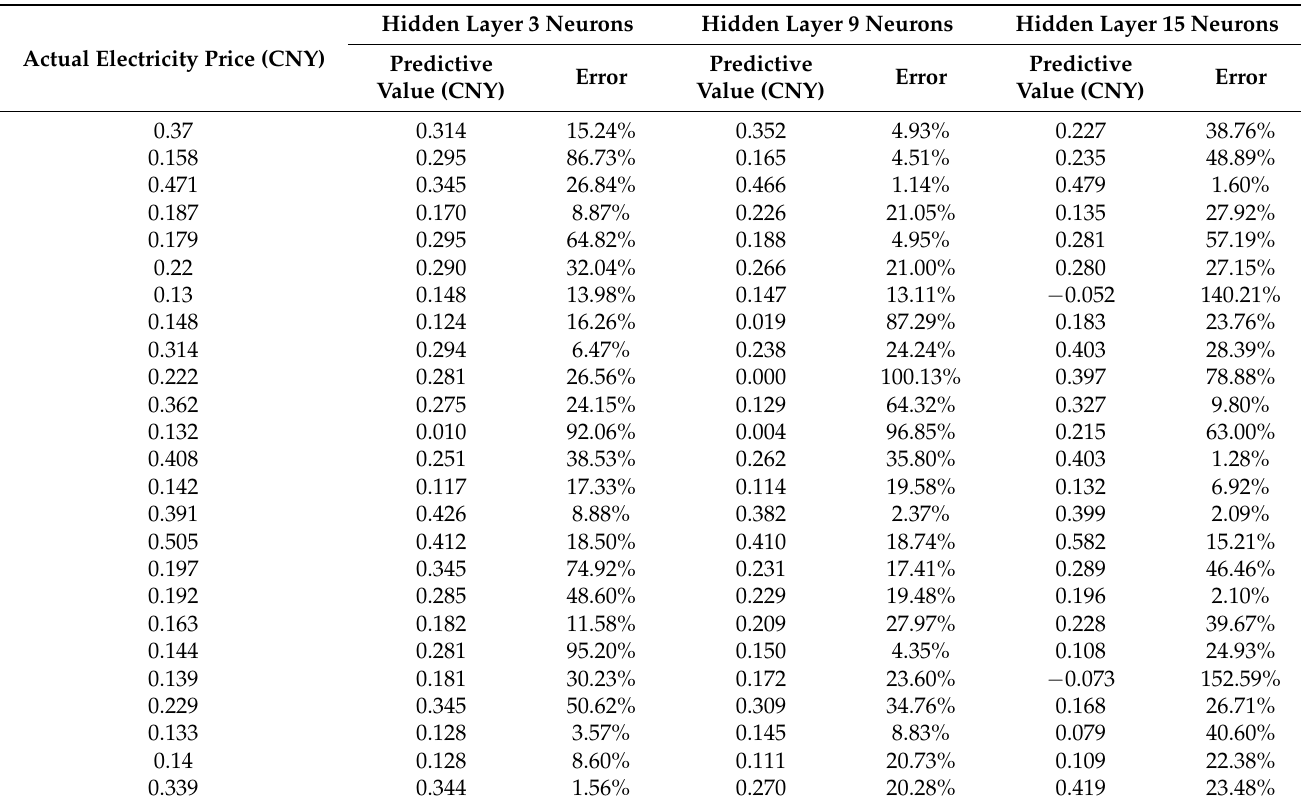
Table 3. Predictive value and error using BP.